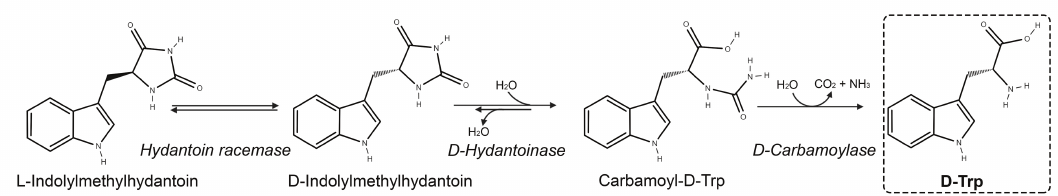
Figure 5. The application of the hydantoinase process to the synthesis of D-tryptophan. In this case, hydantoin racemase from A. aurescens was coupled to D-hydantoinase from A. tumefaciens and D-carbamoylase from A. crystallopoietes